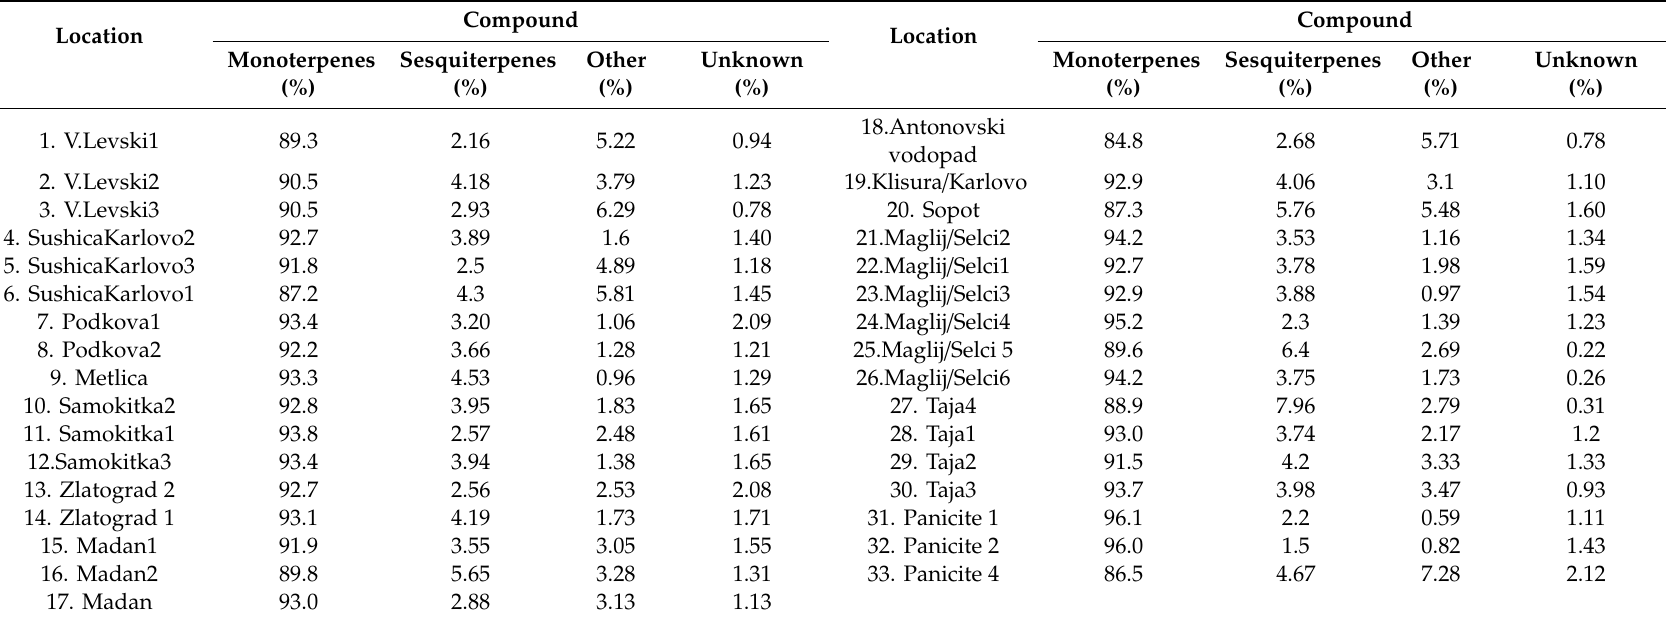
Table 2. The class compounds in Satureja pilosa in di ff erent